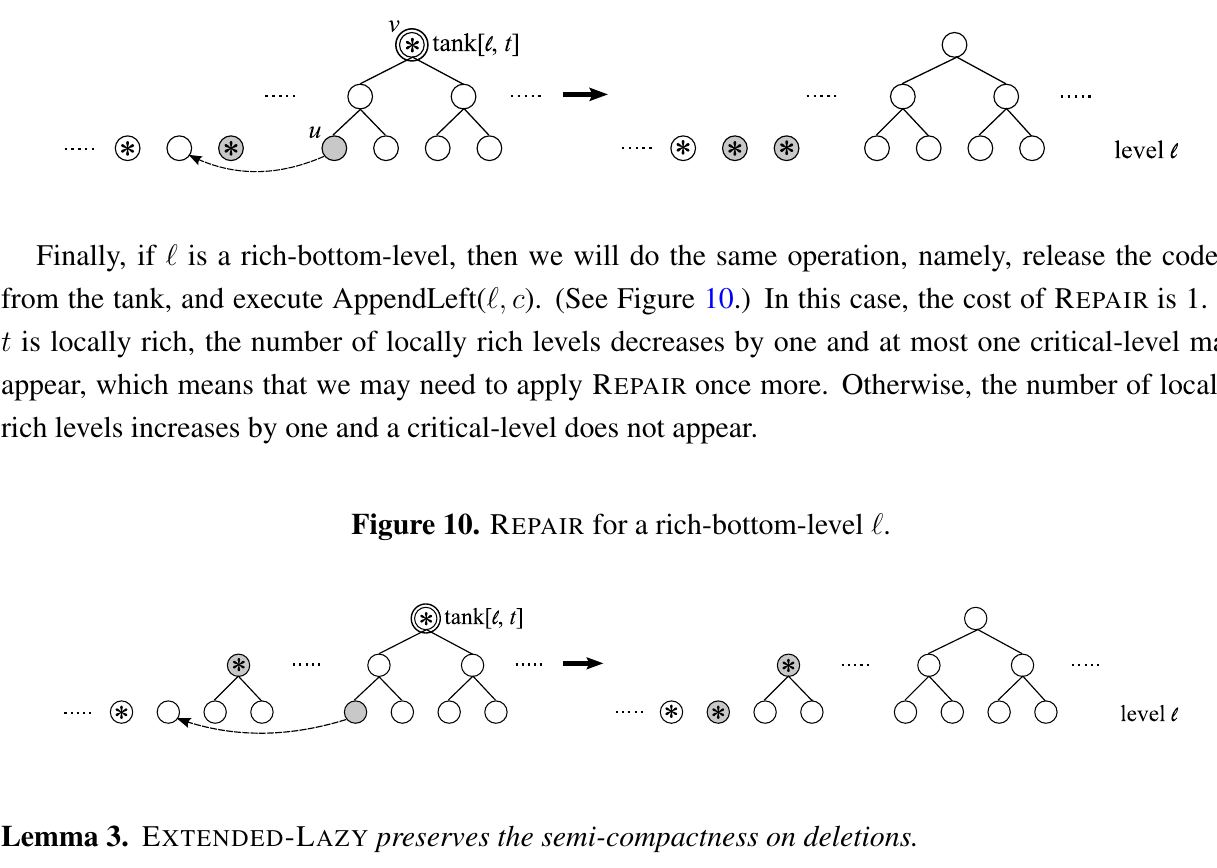
Figure 9. R EPAIR for a hole-level (cid:96) which is a bottom of a tank v .